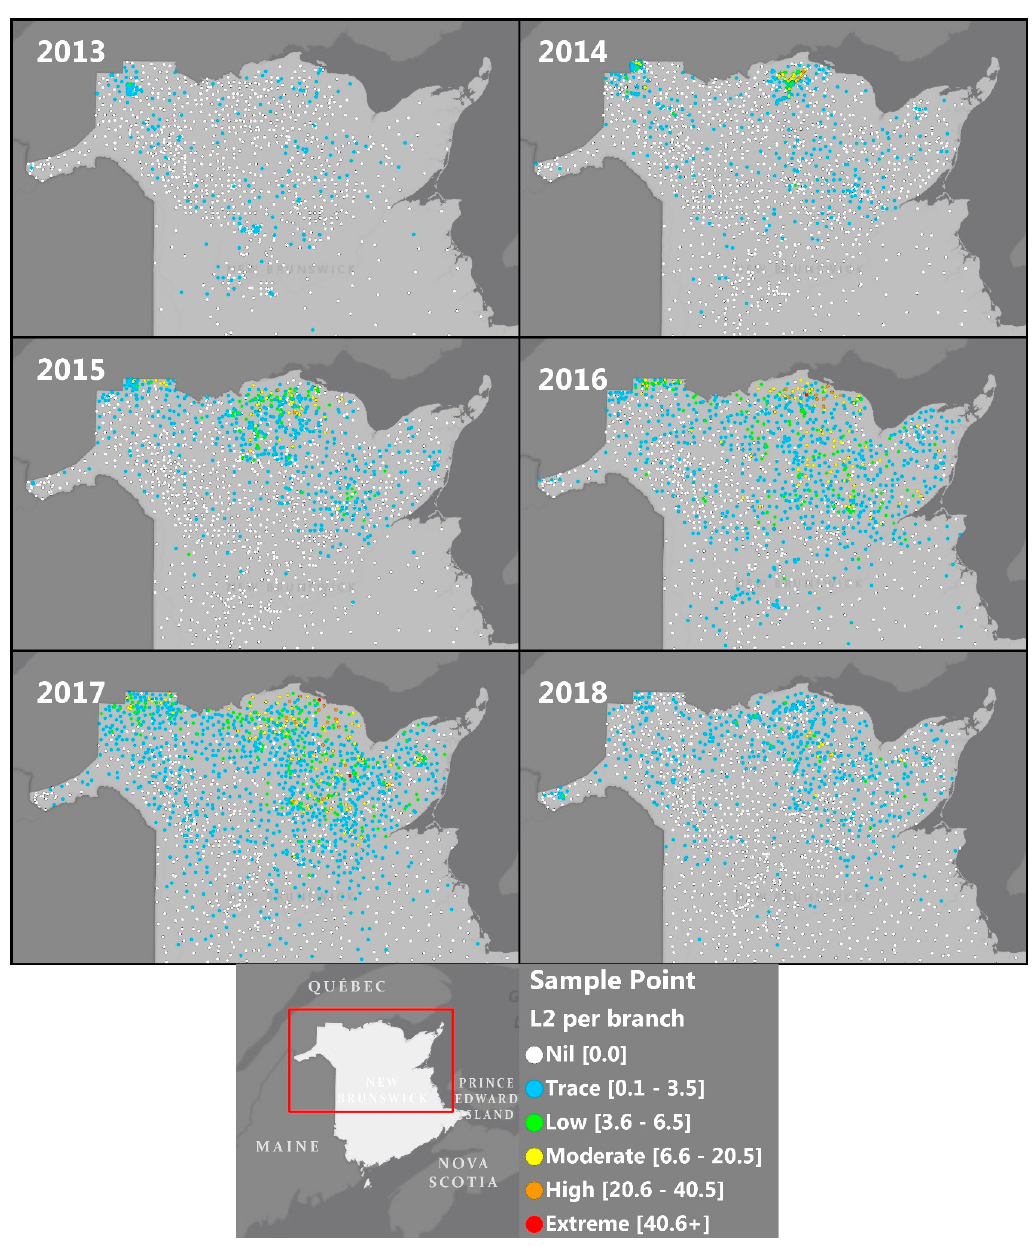
Figure 1. SBW L2 sample points in New Brunswick from 2013 to 2018. These L2 point data were spatially interpolated and used to plan treatment areas (generally ≥ 7 L2 / branch), using an optimized blocking algorithm described in section 2.3.